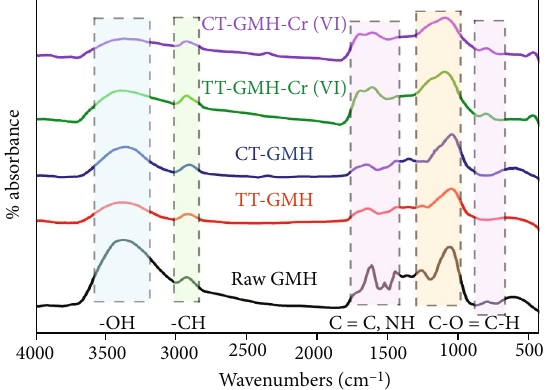
Figure 3: FTIR spectrum of raw GMH and adsorbents TT-GMH and CT-GMH before and after adsorption of